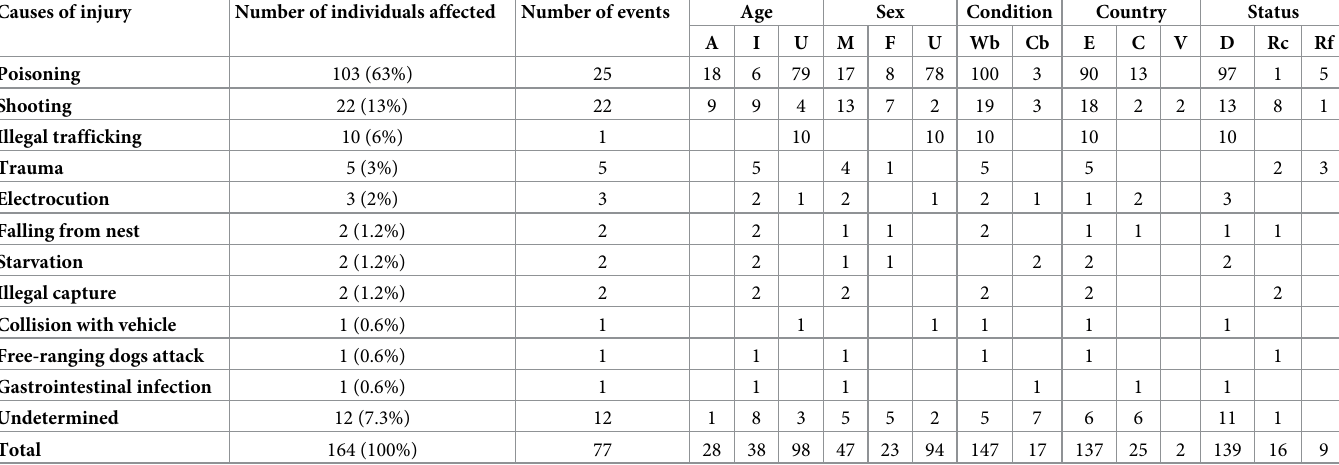
Table 1. Number of Andean Condors affected (percentage values in parenthesis), and number of events by cause of injury, age (A = adult, I = immature, U = unknown), sex (M = male, F = female, U = unknown), individual birth condition (Wb = wild-born, Cb = captive-born), country (E = Ecuador, C = Colombia, V = Venezuela), and individual status (D = dead, Rc = recovered and in captivity, Rf = recovered and free-ranging), in northern South America between 1979 and